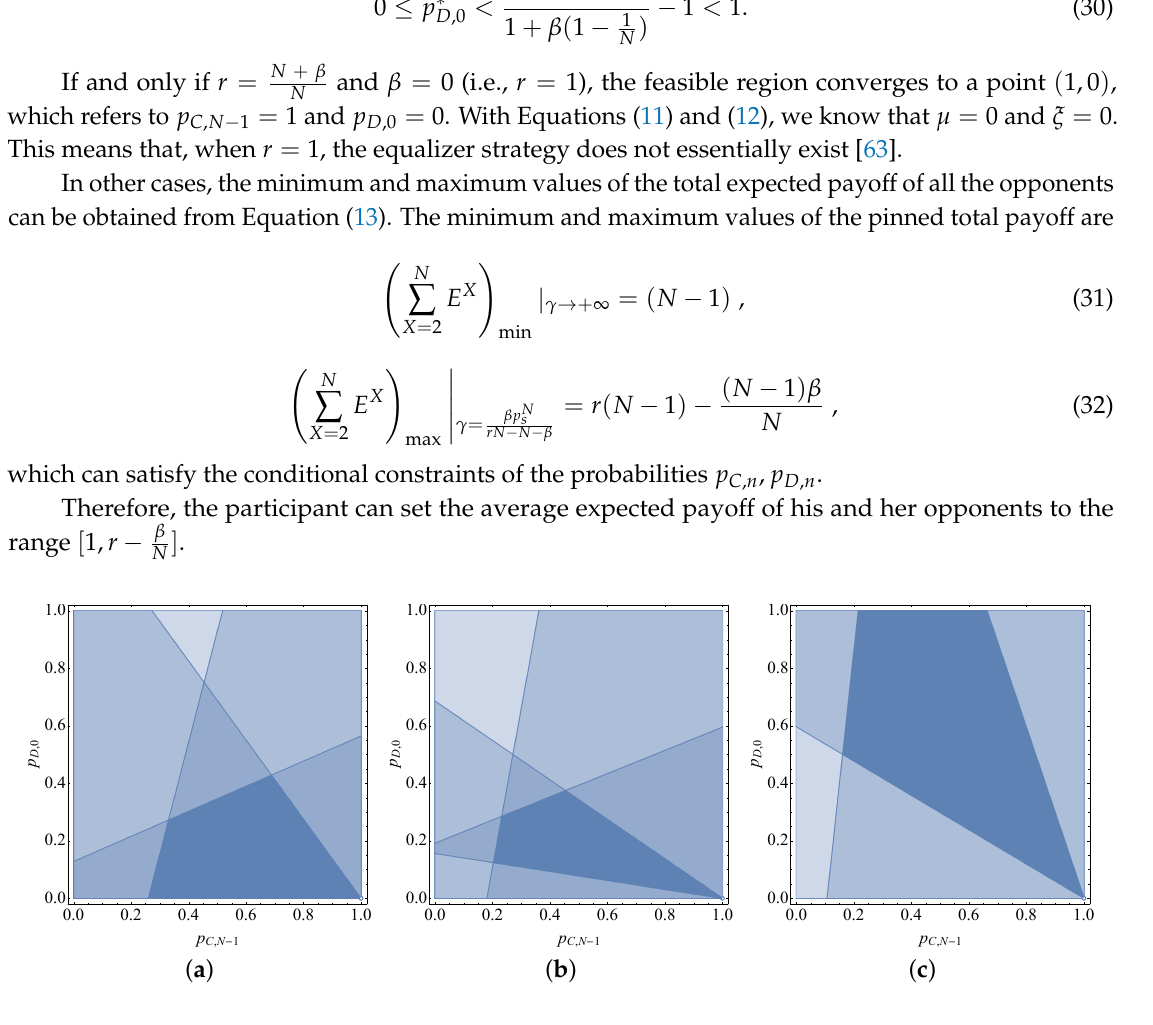
Figure 2. The feasible region for the equalizer strategy [26] (reproduced with permission from Xinyu Yang, Xiaofei He, Jie Lin, Wei Yu, Qingyu Yang, A Game-Theoretic Model on Coalitional Attacks in Smart Grid; published by IEEE, 2016). ( a ) Case 1: r < N + β ( c ) Case 3: r > N N − 1